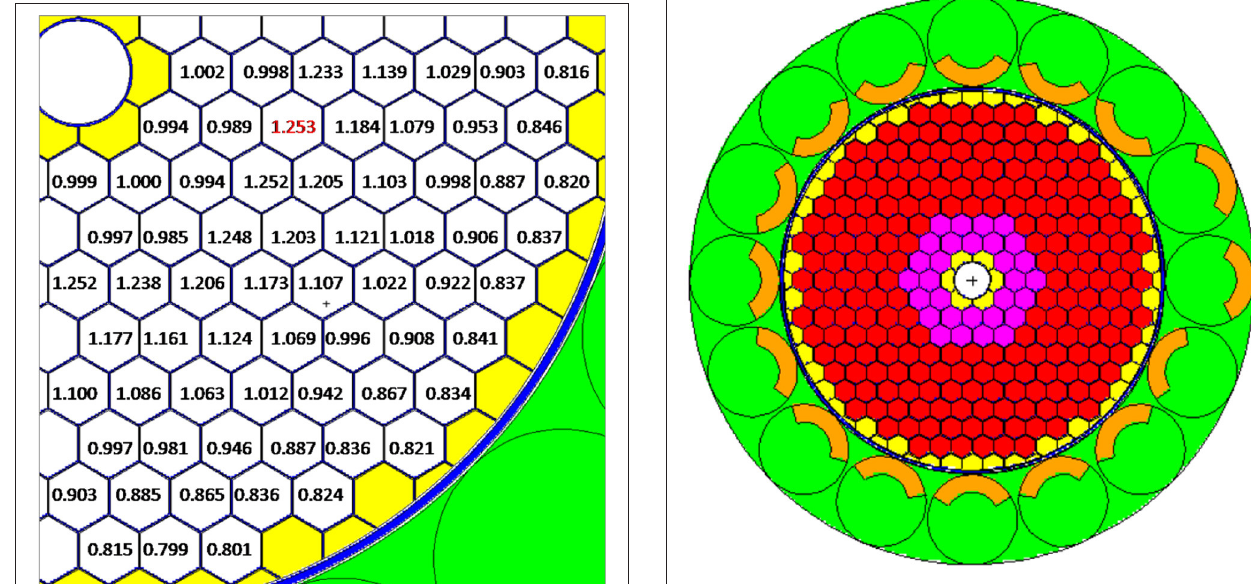
FIGURE 5 | Normalized thermal power distribution of 1/4 core.